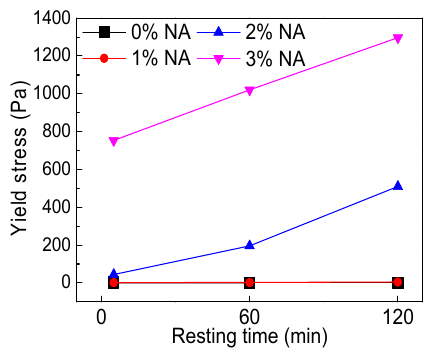
Figure 23. Influence of NA on τ 0 .